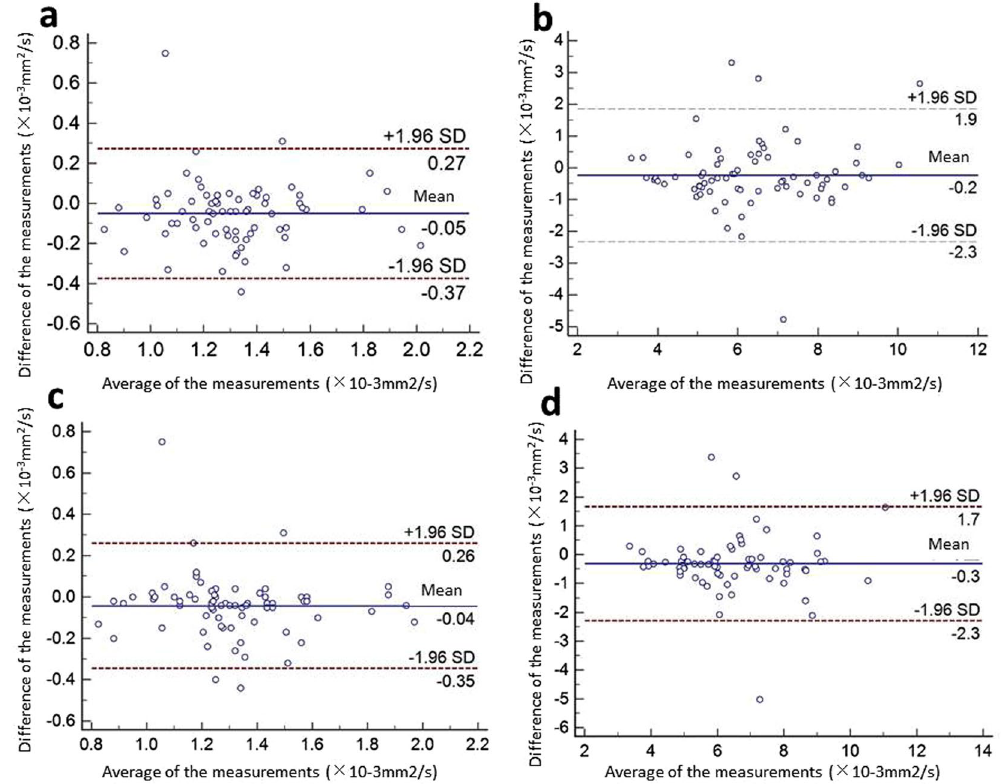
Figure 1. Bland-Altman plots of inter- and intra-observer agreement. The calculation of ADCs ( a ) and puborectalis thickness ( b ) between radiologists A and B; the calculation of ADCs ( c ) and puborectalis thickness ( d ) for the same radiologist. The solid lines indicate the mean of the differences between measurements. The dashed lines indicate the 95% limits of agreement, defined as the mean difference ± 1.96 (standard deviation) of the